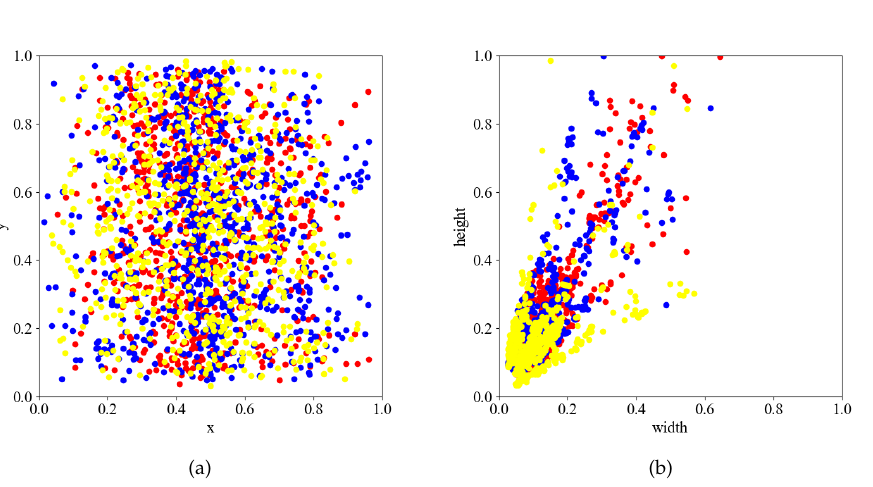
Figure 9. Distribution of ground truth bounding boxes of UAVT-3, in which each color denotes one class tank. ( a ) Distribution of object center points. ( b ) Distribution of object